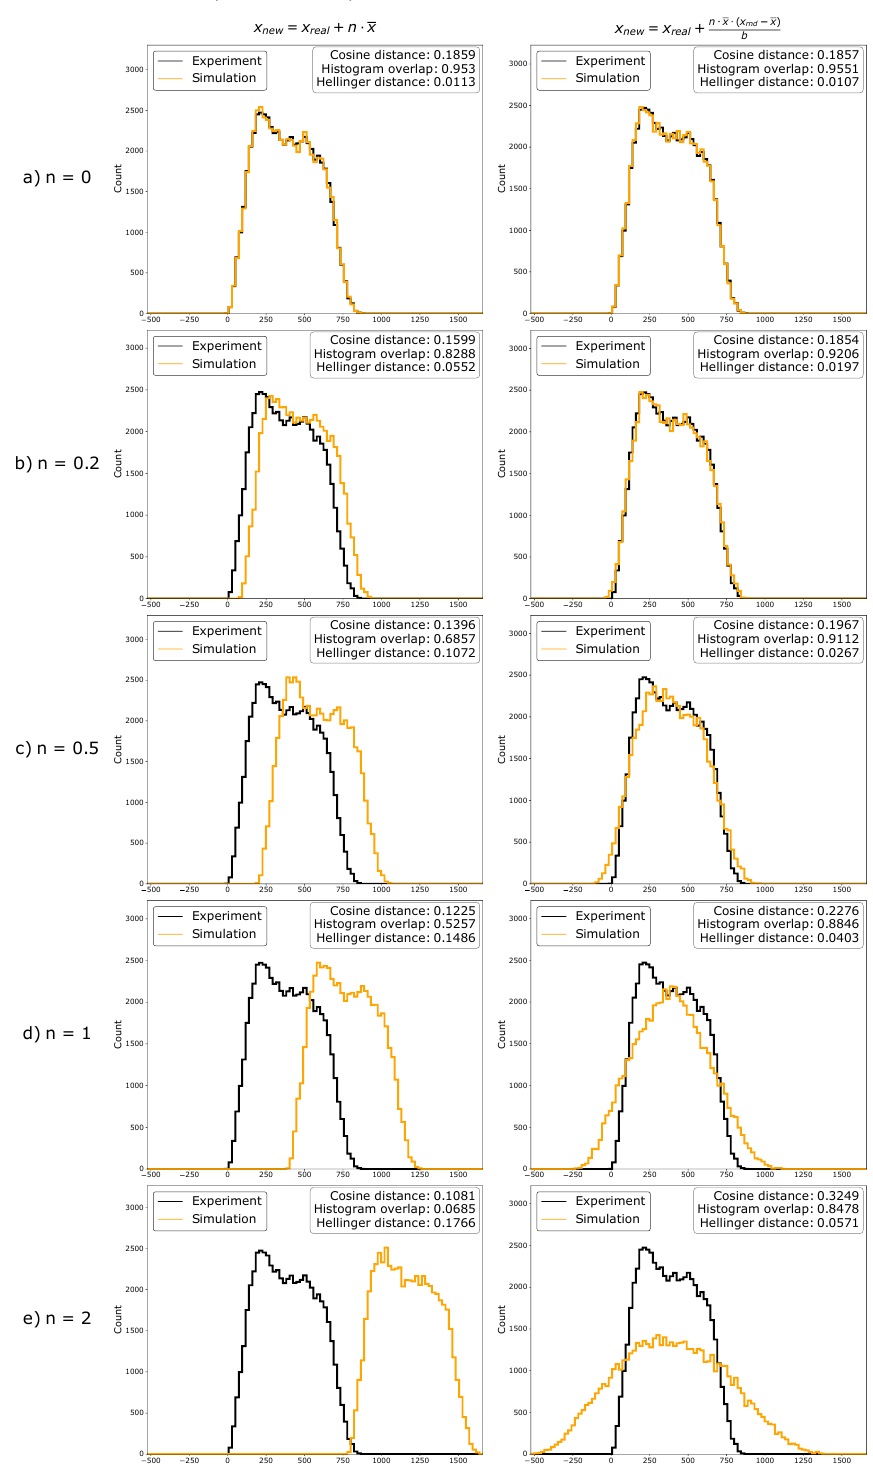
Figure 2. Overlaid histograms of experimental data (black) and simulated data (orange) transformed with factor n . Experimental data were used to generate simulated data, as explained in Section 4.9. Different magnitudes of changes (as indicated with their n -value) were tested. Cosine distance and Hellinger distance, as well as histogram overlap were calculated. Here, data can be effectively simulated by inverse transform sampling. Distributions can be effectively shifted or spread by using functions x new = x exp + n · ¯ x (for shifting of distributions) or x new = x exp + spreading of distributions) before inverse transform